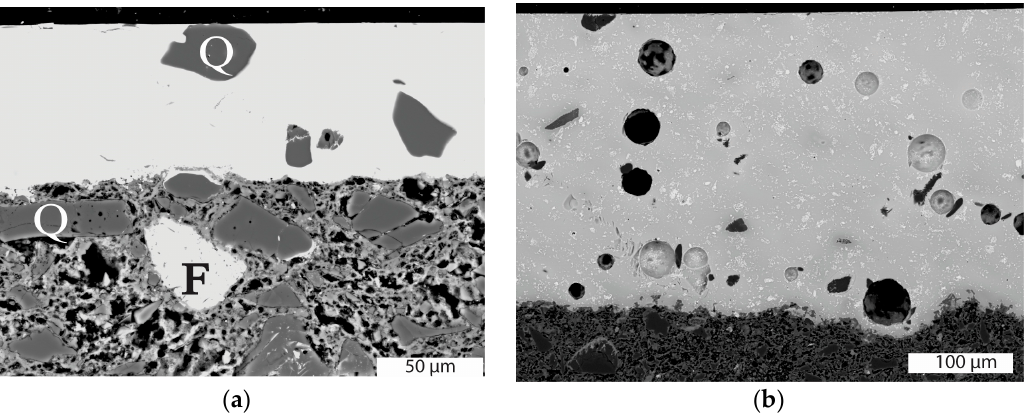
Figure 10. SEM-BSE image of sections through the glaze (top) and the body (below) of French CaO-rich white earthenwares from Lorraine. ( a ) Cassiterite-free SiO 2 -PbO glaze with few corroded, former angular quartz inclusions of the same granulometry as those in the body. The body is rich in angular quartz (Q)- and lead frit (F)-fragments. No reaction zone between the glaze and the body. Niderviller, Sample BER 16 [25]; ( b ) Cassiterite-bearing lead glaze with many gas bubbles and small crystalline inclusions of quartz and feldspar. No reaction zone between the glaze and the body. Saint-Cl é ment, TBL 21